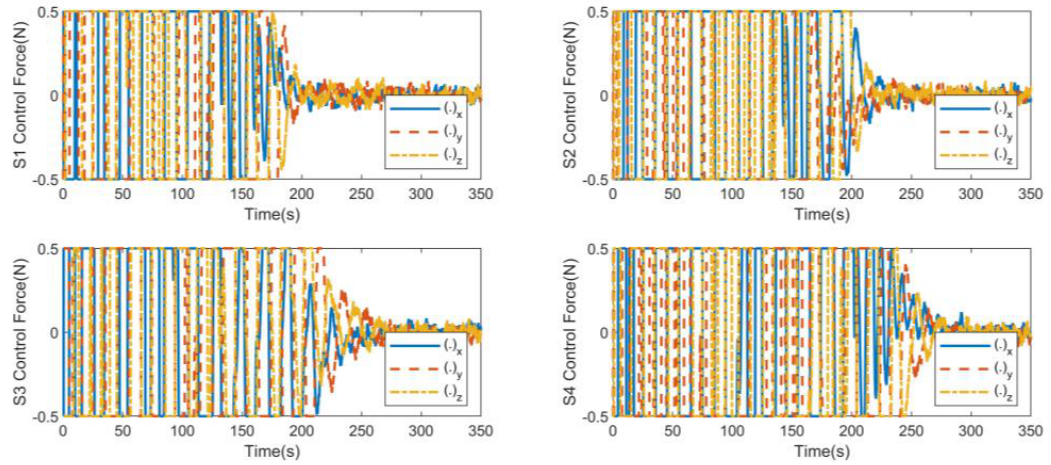
Figure 7. S1, S2, S3, S4 control force for non-consistent collaborative control.